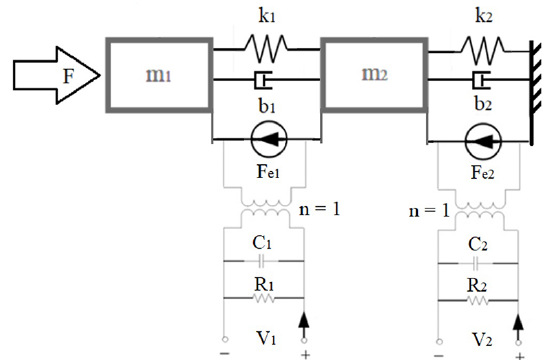
Figure 13. Modified hypergraph of a piezo stack constrained on one side and excited by the force F on the other.